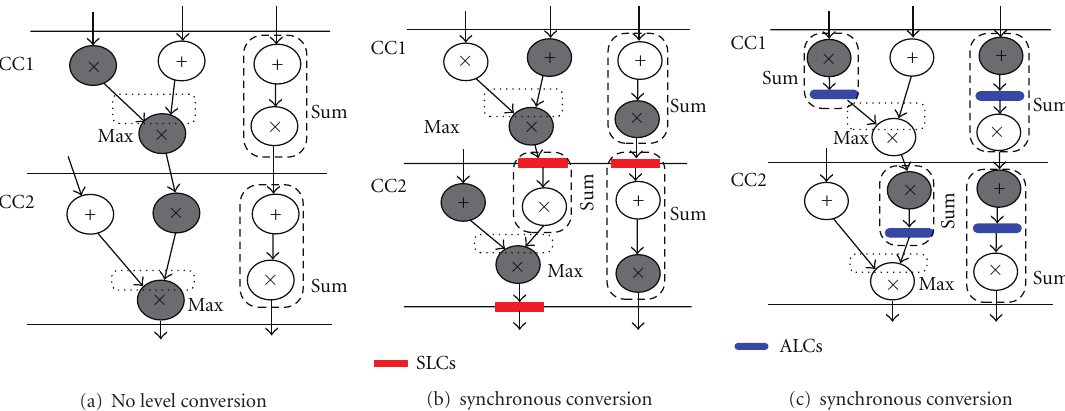
Figure 6: Timing yield computation in multi- V dd high-level synthesis with di ff erent level conversions. Shadowed operations are bound to function units with low-supply voltages, and the bars indicate the insertion of level